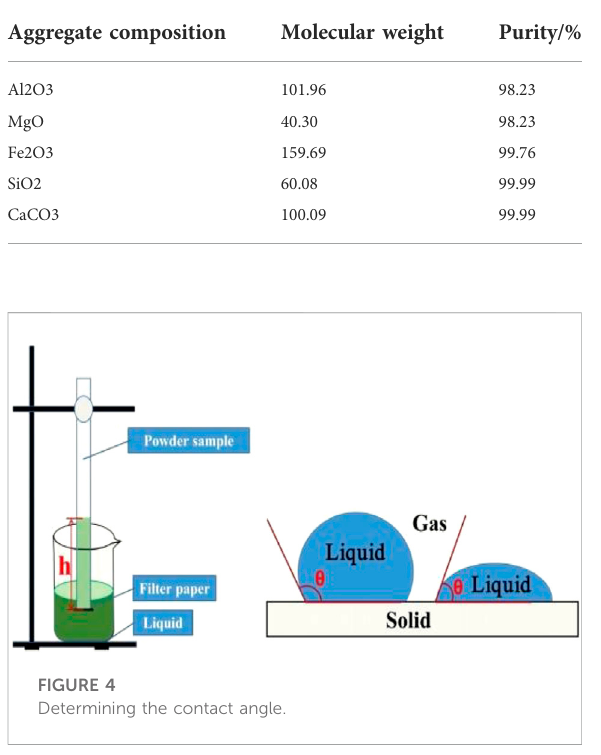
FIGURE 4 Determining the contact angle.